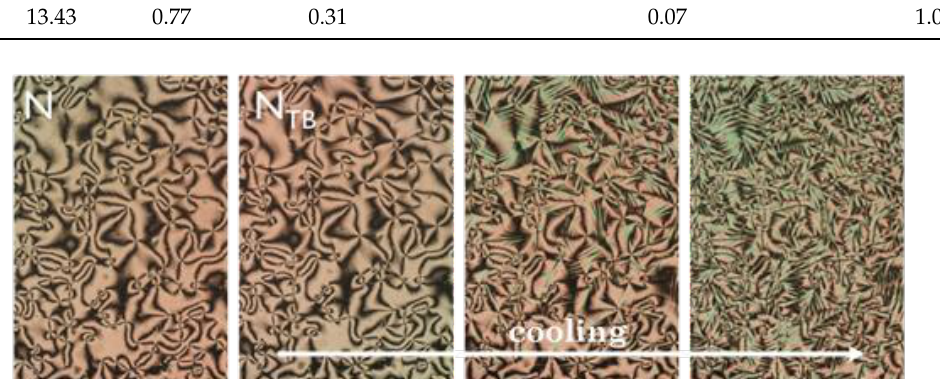
Table 1. Transition temperatures and associated entropy changes for the CB6OBA: n OS mixtures. *Temperature obtained from DSC cooling trace. †Temperature obtained from POM. ⁑